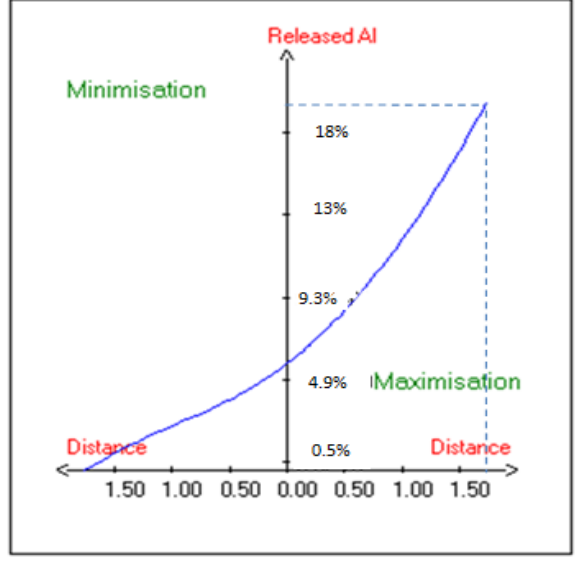
Figure 8. Percentage of released Al as a function of distance.